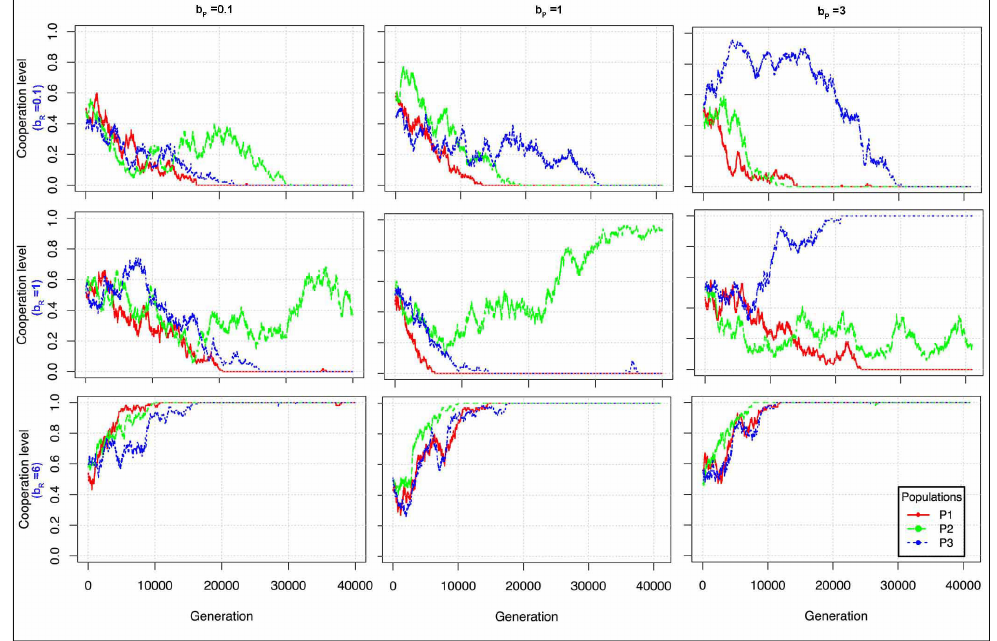
Figure 2. Typical simulation runs showing the cooperation levels over time in the three populations (red for Public, blue for Private and green for Patient). The plots represent the frequency of cooperation adopted by the populations for different values of b and b . Other parameters as in Figure 1. R P